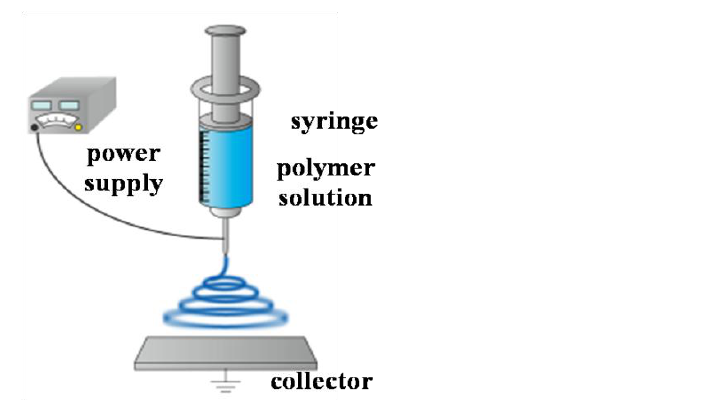
Figure 1. Schematic illustration of electrospinning